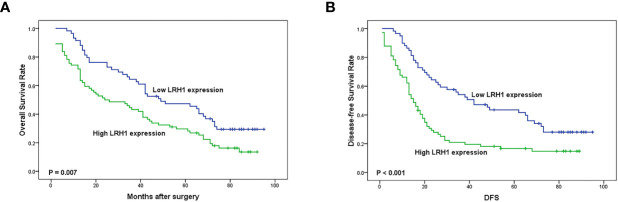
Kaplan–Meier analysis of overall survival (OS) and disease-free survival (DFS) related to the expression of LRH1. (A) OS curves of the 133 OC patients; (B) DFS curves of the 133 OC patients.